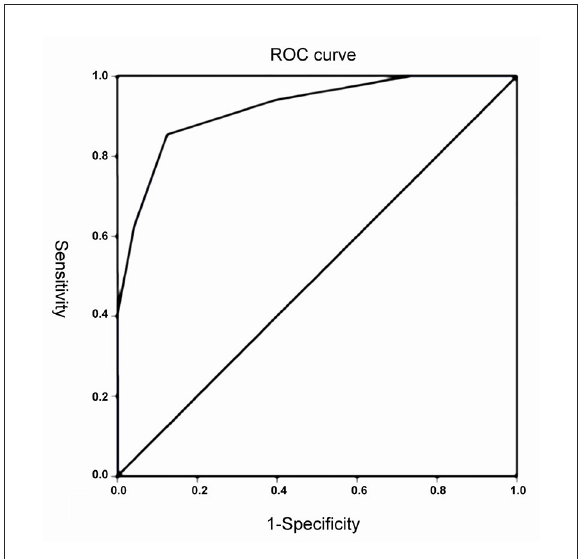
FIGURE1 The receiver operating characteristic (ROC) curve of the Modified Early Warning Score (MEWS) combined score for predicting the hospitalization of patients.